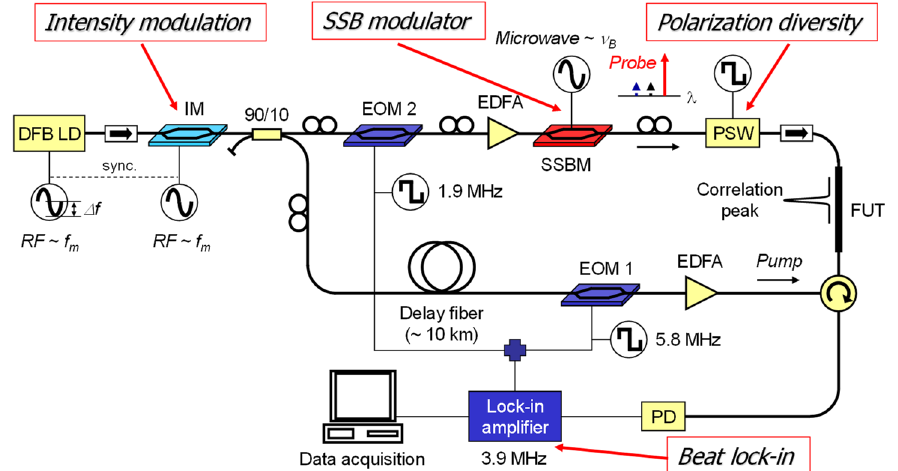
Figure 21. Example of the BOCDA systems that include three performance improvement schemes: the intensity modulation scheme, the time-division polarization diversity scheme, and the beat lock-in detection scheme [51,57,66].